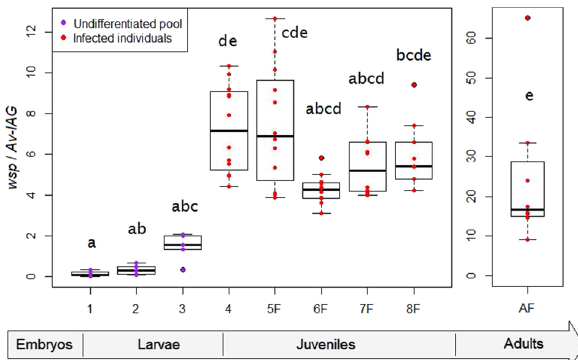
Figure 1. Evolution of the Wolbachia load during development in the Wolbachia -infected lineage of A. vulgare . The number of bacteria was estimated by qPCR using the wsp gene, normalised by the single copy nuclear gene Av-IAG from the host. Pools of undifferentiated larvae were sampled after birth (stage 1), one and two weeks after birth (stages 2 and 3, respectively). For the next developmental steps, Wolbachia -infected animals were sampled individually: undifferentiated juveniles (stage 4), and phenotypic females (stages 5–8) until adulthood (AF for adult